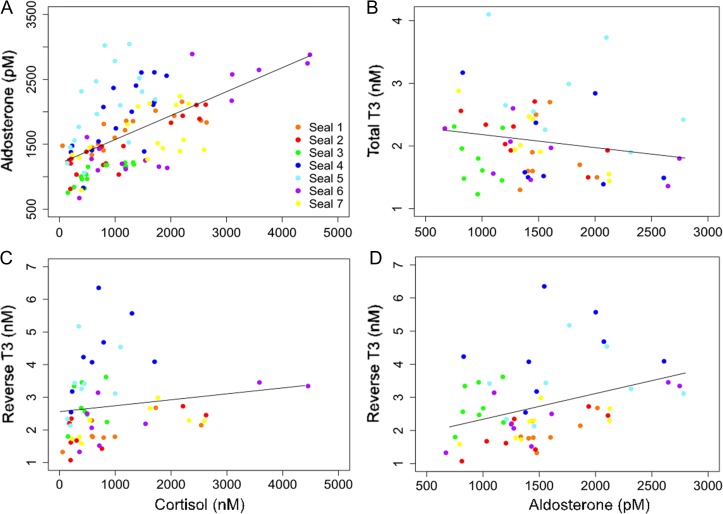
Associations between hormone levels in samples collected during the experiment. (A) Cortisol and aldosterone were positively associated (LMM: F1, 106.8 = 105, P < 0.0001; mR2 = 0.38). (B) Aldosterone and total T3 were negatively associated (LMM: F1, 53.5 = 8.26, P < 0.001; mR2 = 0.12). (C) Cortisol and reverse T3 were positively associated (LMM: F1, 7.47 = 6.38, P < 0.05; mR2 = 0.29). (D) Aldosterone and reverse T3 were positively associated (LMM: F1, 7.66 = 5.88, P < 0.05; mR2 = 0.26).